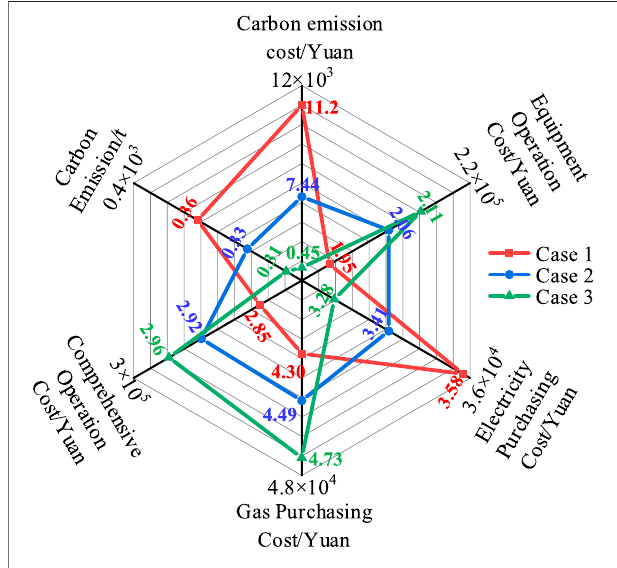
FIGURE 4 | Low-carbon economic dispatch